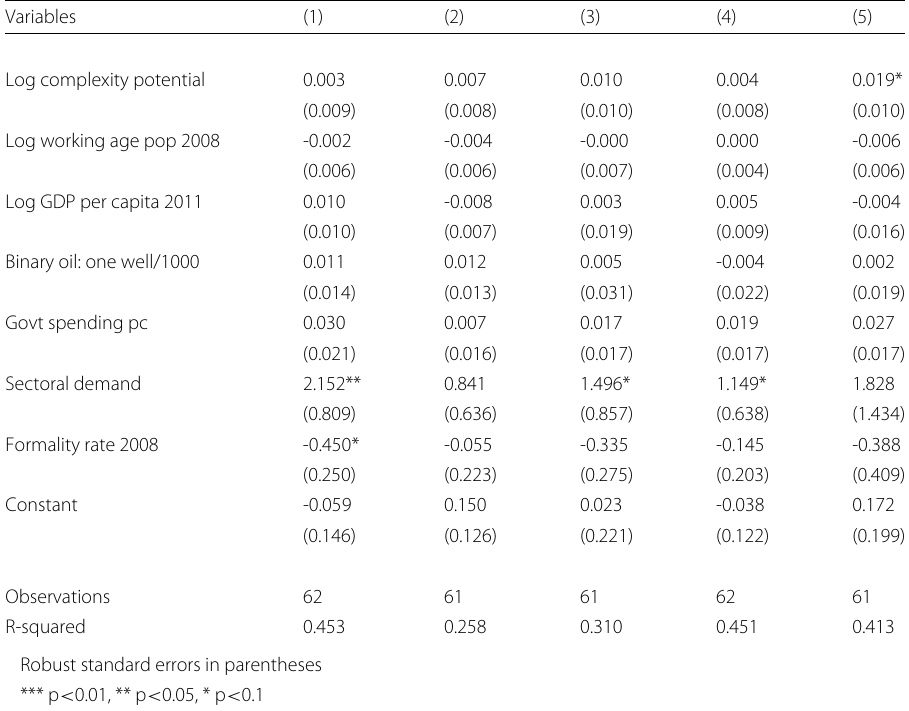
Table 3 Here we assign municipalities randomly to 62 cities in five successive placebo cases and replicate the last regression (column 5) of the previous tables in each